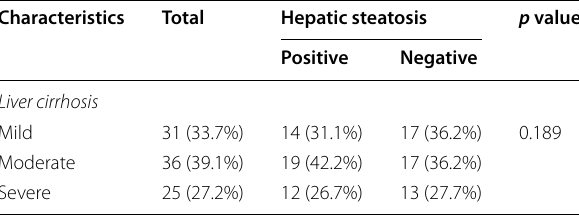
Fig. 6 A 40-year-old male patient with moderate cirrhosis and a single HCC lesion in segments VIII, VII, V, and IV. A Early arterial phase, B delayed phase C T2WI, D diffusion WI E ADC map, F in-phase gradient echo, G opposed phase gradient echo H in-phase gradient echo measuring the fat fraction within the lesion, I opposed phase gradient echo measuring the fat fraction within the lesion.The lesion elicits moderate high T2 signals with restricted diffusion and shows early non-rim APHE and non-peripheral contrast washout. Hepatic fat fraction: 5.8% (Mild steatosis). Major HCC features: non-rim APHE (early), non-peripheral “washout” (late) and size 13.5 14.5 cm. Ancillary HCC features favoring malignancy: Moderate T2 = × hyperintensity, restricted diffusion and fat sparing in solid mass “Relative paucity of fat in solid mass relative to steatotic liver”: (fat fraction in the lesion 0%) = Table 5 Correlation of steatosis degree with LI-RADS major and Table 6 Comparison between positive and negative hepatic ancillary HCC features steatosis patients according to presence liver